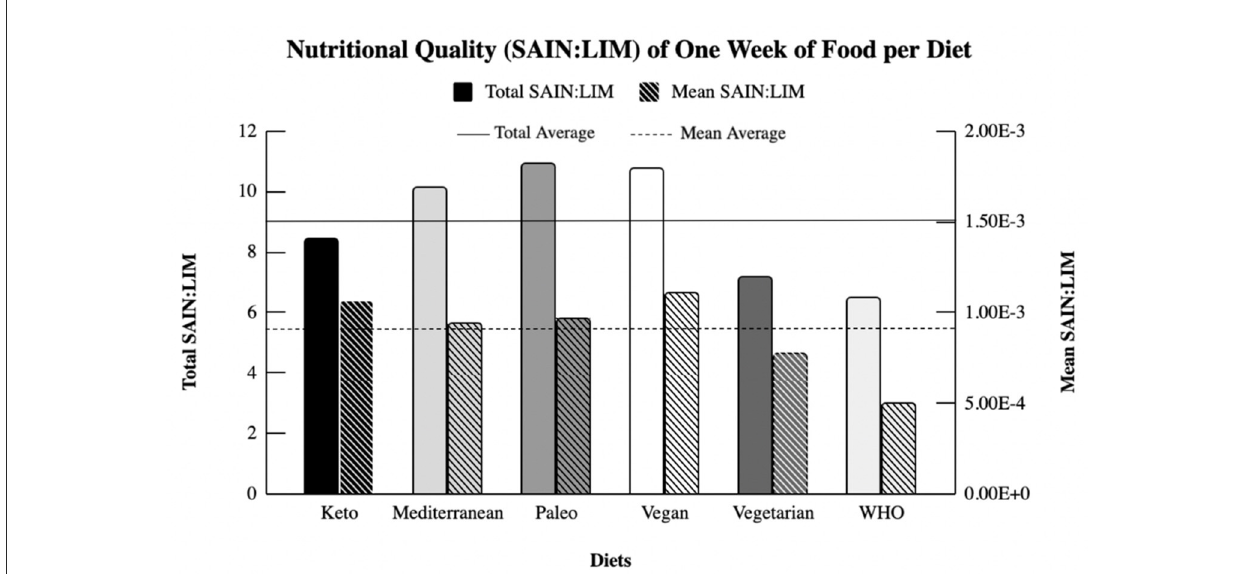
FIGURE2 Nutritional quality, shown as the SAIN:LIM ratio, calculated for each diet for 1 week of meals at 2,000 kilocalories/day. Total SAIN:LIM [ (Left) Y-axis] is calculated by summing the SAIN:LIM ratios of all food items within a diet, adjusted to each food’s quantity in grams. The accompanying solid line shows the average of total SAIN:LIM ratios across all diets. Mean SAIN:LIM [ (Right) Y-axis] is calculated by dividing a diet’s total SAIN:LIM ratio by the quantity of food grams within that diet, resulting in a mean value. The accompanying dashed line shows the average of mean SAIN:LIM ratios across all diets. SAIN:LIM is a ratio composed of beneficial nutrients in a food item (protein, fiber, calcium, vitamin C, and iron) divided by its maleficial nutrients (saturated fatty acids, added sugars, and sodium) and weighted by their respective